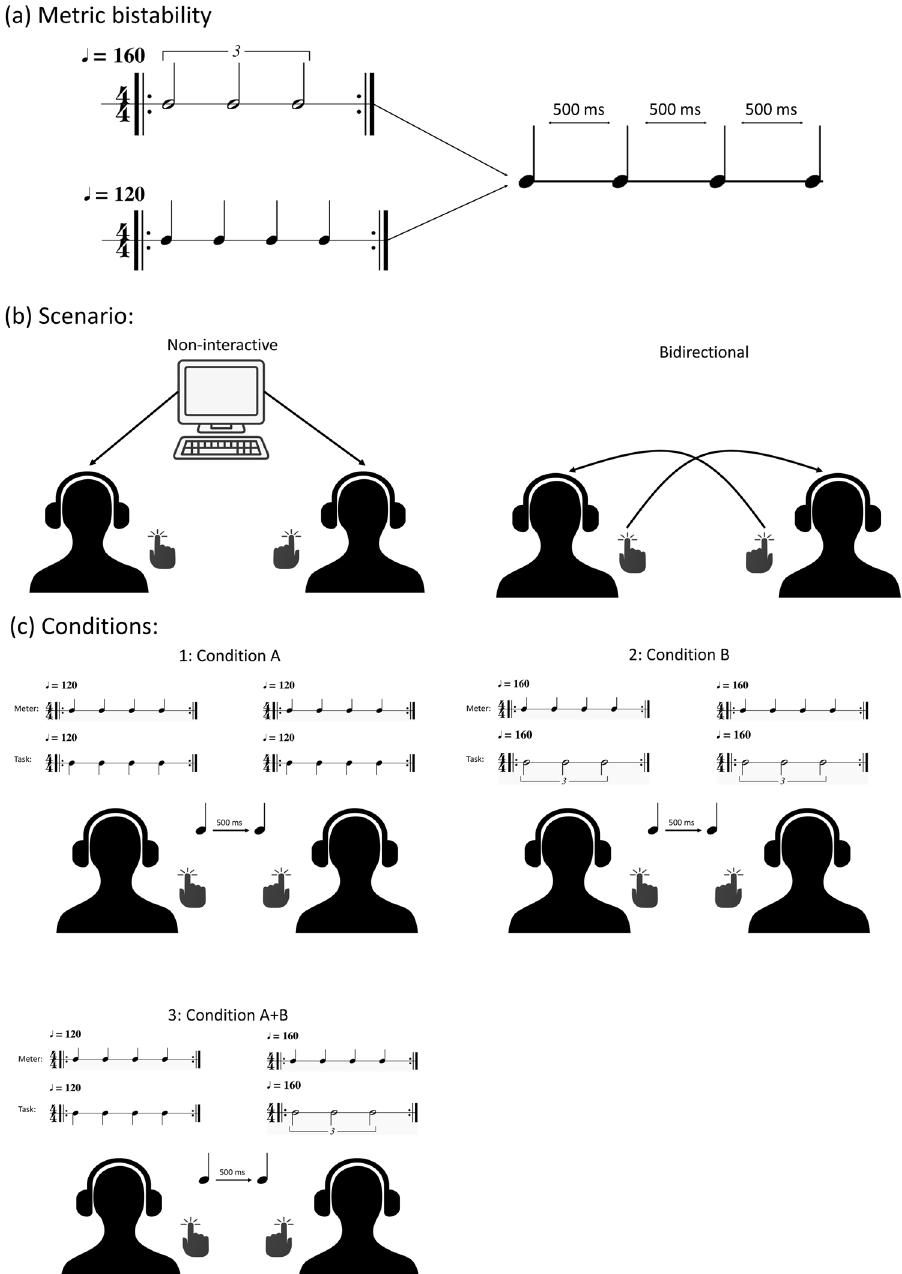
Figure 2. ( a ) An illustration of how an isochronous rhythmic sequence with a 500 ms ITI can be resolved into two distinct rhythms – a 3-against-4 polyrhythm at 160 BPM, and a 4/4 straight rhythm at 120 BPM. ( b ) The two scenarios in our experiment. Participants either tapped along with a computer metronome – the non- interactive condition; or in a bidirectionally coupled state. ( c ) An overview of the conditions, showing both the meter and the task. Note that condition A + B is balanced, so that both member 1 and member 2 performs the two distinct rhythms an equal amount of